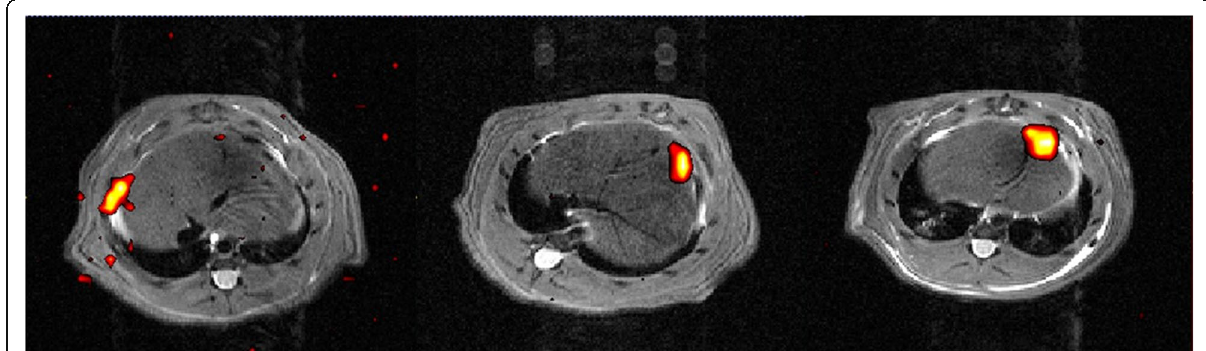
Fig. 4 19 F magnetic resonance imaging (MRI) of Cell Sense ATM DM Red mesenchymal stromal cell-injected animals at T 0 (left), T24 (centre), and T 48 (right) after inoculation. Red-scale images are 19 F MRI while underlying greyscale images are 1 H anatomical MRI. Slices corresponding to the maximum 19 F signal localisation are